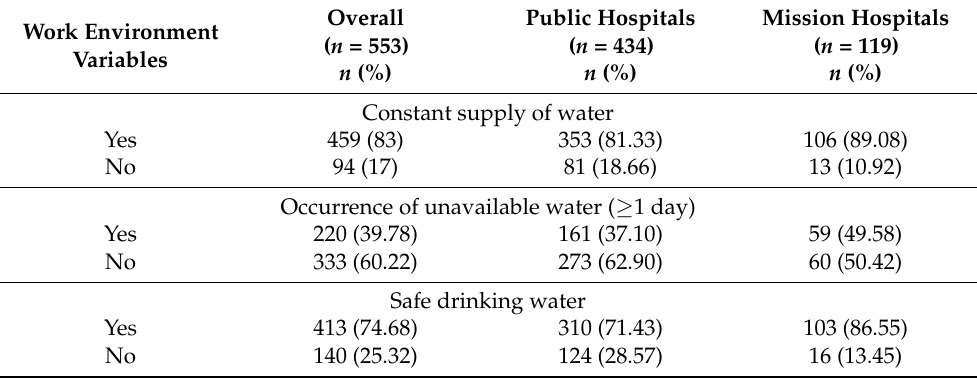
Table 2. Overall and sub-sample percentage frequency distribution of work environment characteris- tics ( n =